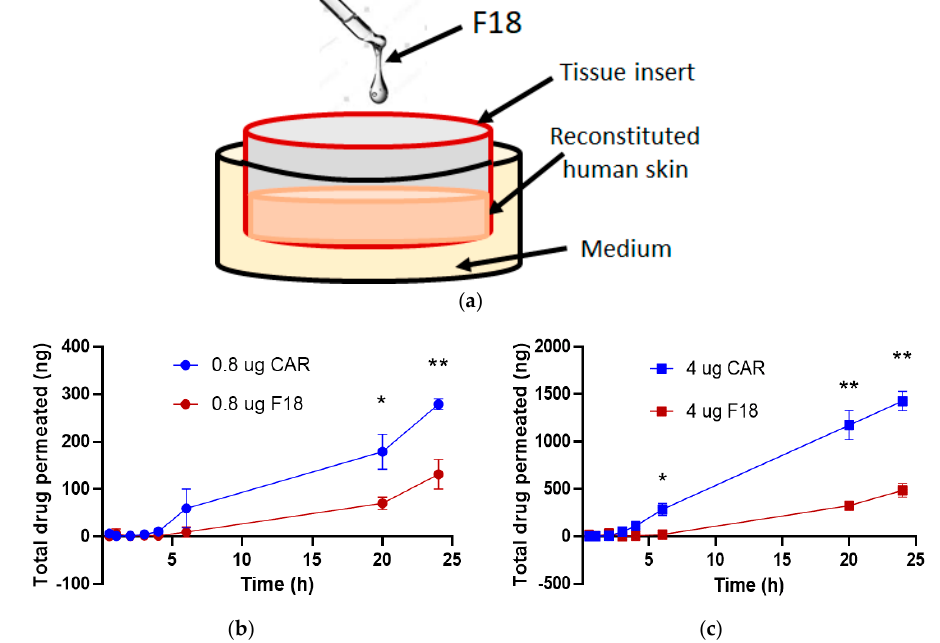
Figure 6. Carvedilol permeation in the reconstituted human 3D skin culture. ( a ) Schematic representation of Table 400. Treatment with F18 containing 0.8 μ g ( b ), or 4 μ g ( c ) carvedilol, or free drug of the same doses were applied to the surface of the skin culture and incubated for 24 h. Carvedilol levels within the medium under the membrane was measured as described in the Methods. Values are presented as the means ± SD of three wells (* p < 0.05, ** p <